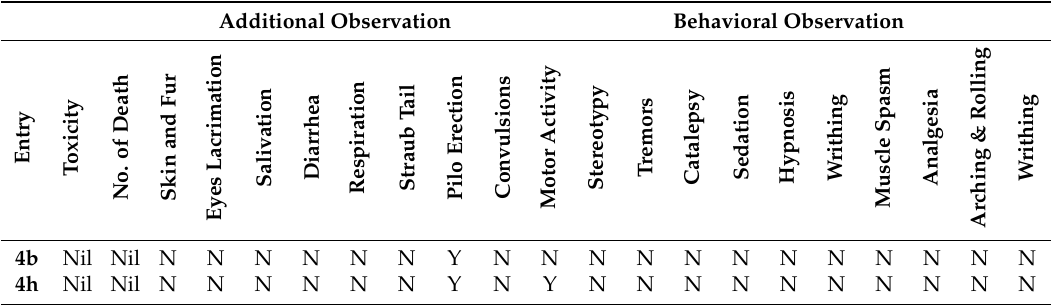
Table 6. In vivo acute oral toxicity study and gross behavioral studies of the compounds 4b and 4h